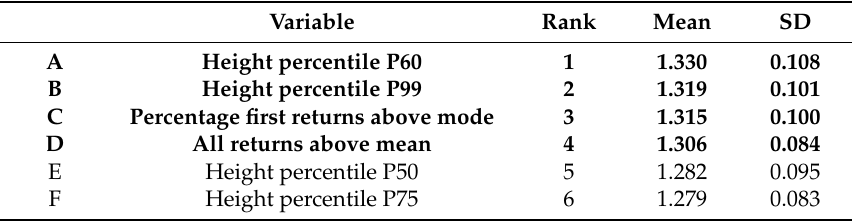
Table 2. Variable importance classification of k NN models between biomass and SOC C stocks and LiDAR metrics of Pinus halepensis plantations at Los Cuadros (Murcia, Spain). In bold are shown the variables selected to run the models. Variable Rank Mean SD Height percentile